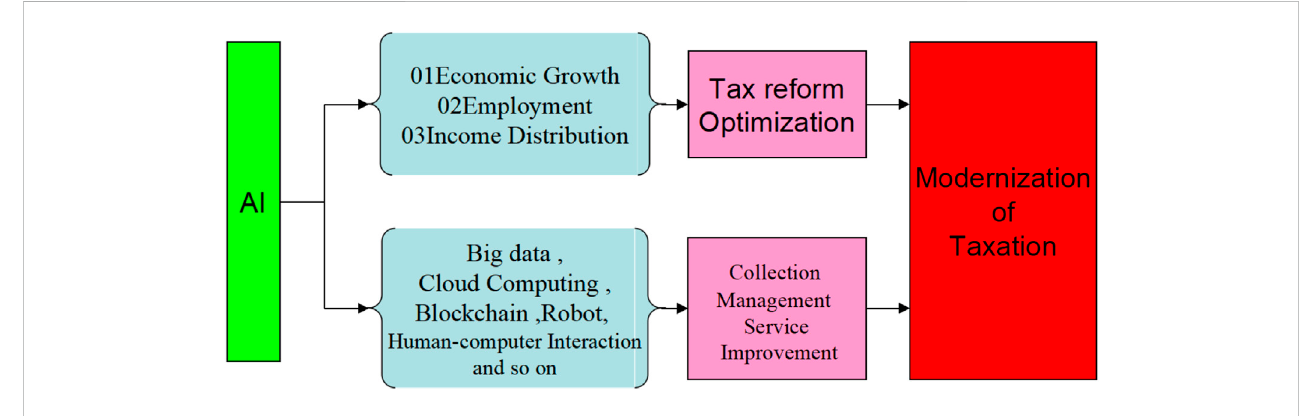
FIGURE 2 Effects of arti fi cial intelligence on tax